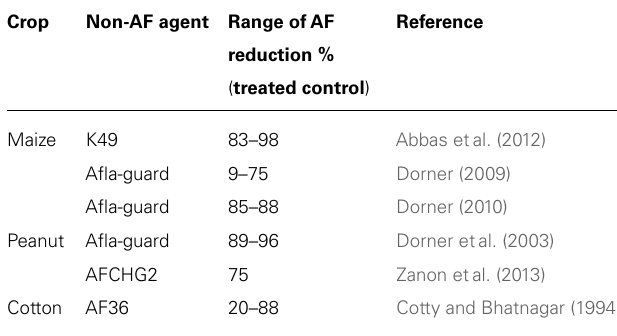
Table 2 | Efficacy of biocontrol